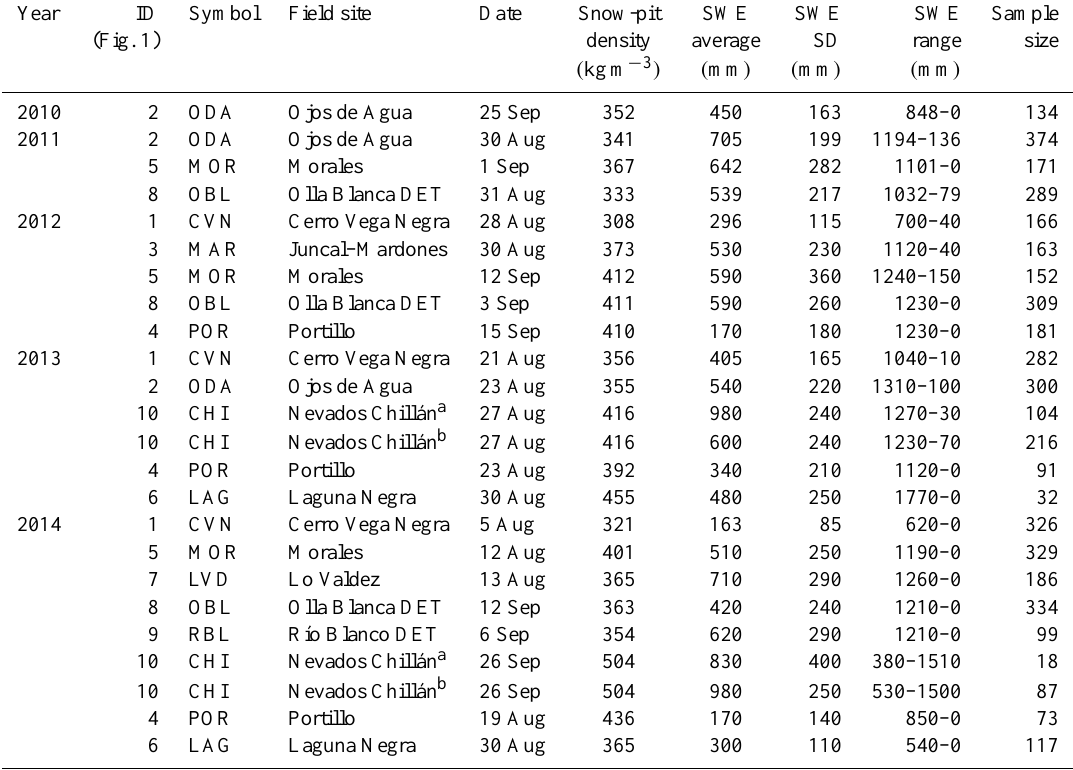
Table 3. Summary of snow depth and density intensive study